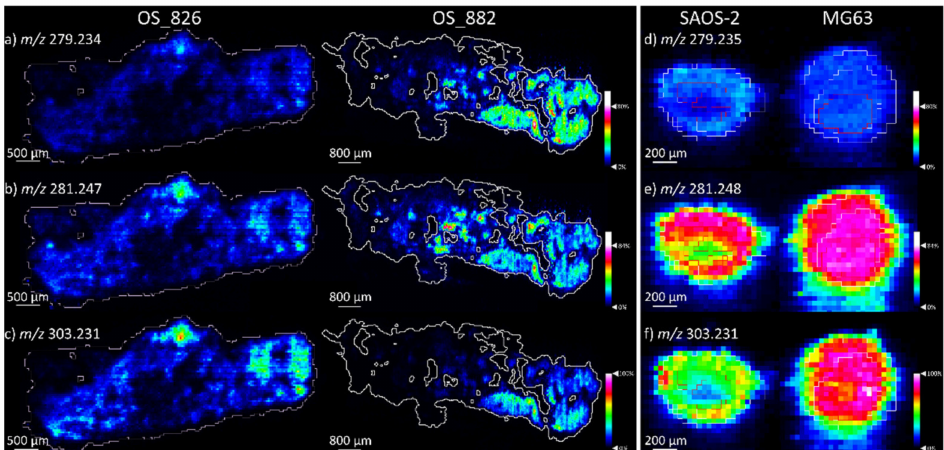
Figure 8. Fatty acid detection within OS human tissue and OS aggregoid models. Ion density maps of metabolites in OS patient_826 and OS patient_882. Scale bar 500 µ m and 800 µ m, respectively. Ion density maps of aggregoid models outlining the core and outer area. Scale bar 200 µ m. Peaks identified in human tissue ( a ) m / z 279.234, FA 18:2; ( b ) m / z 281.247, FA 18:1; ( c ) m / z 303.231, FA 20:4. Peaks identified in OS models ( d ) m / z 279.235, FA 18:2; ( e ) m / z 281.248, FA 18:1; ( f ) m / z 303.231, FA 20:4. Mean intensity bar graph for each included in Supplementary Figure S1.